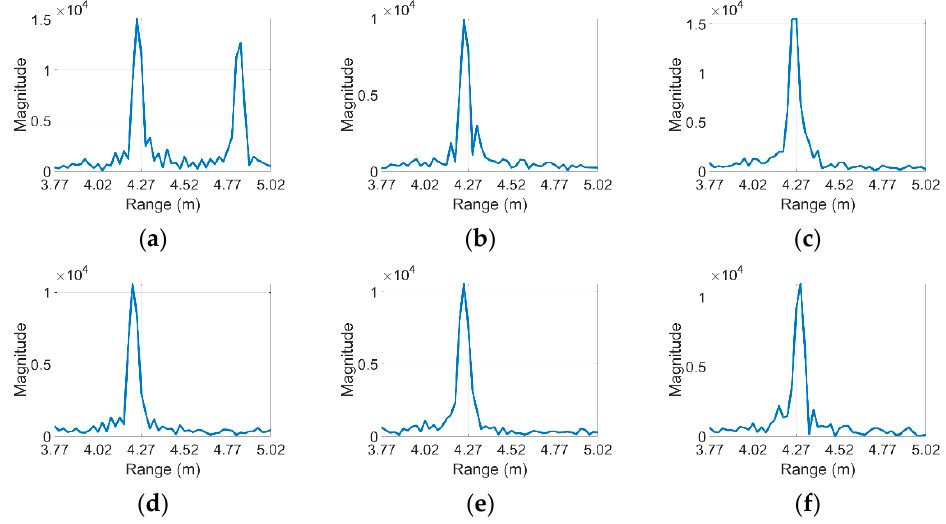
Figure 7. The range-profile plot of the following materials: ( a ) bubble-wrap; ( b ) clothes; ( c ) water; ( d ) mulch; ( e ) soil; and ( f ) granite pebbles.